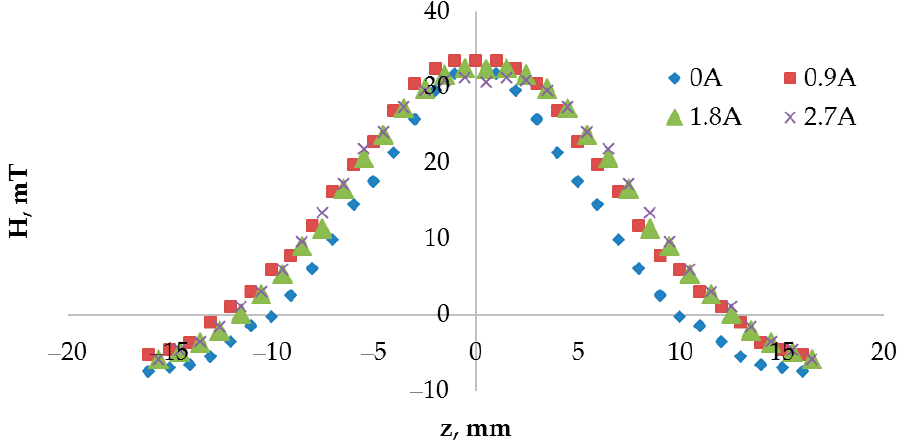
Figure 2. The axial component of the magnetic field intensity is created by a combined source comprised of a permanent annular magnet and an electromagnet in dependence on the z coordi-